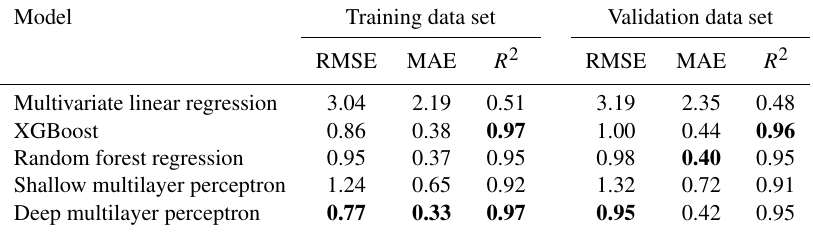
Table 1. Performance of different models in estimating additional melt from the regional atmospheric climate model ver- sion 2.3p2 (RACMO2) simulations. The training data set is the augmented automatic weather station (AWS) observations from AWS 14 and AWS 17, and the validation data set is the augmented AWS observations from AWS